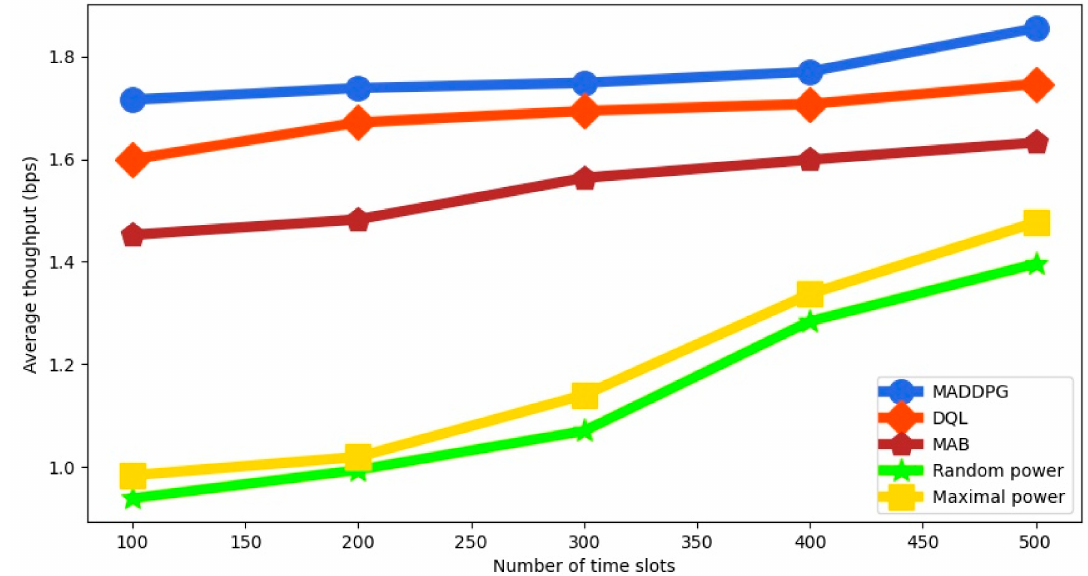
Figure 4. Average throughput as a function of the number of time slots.